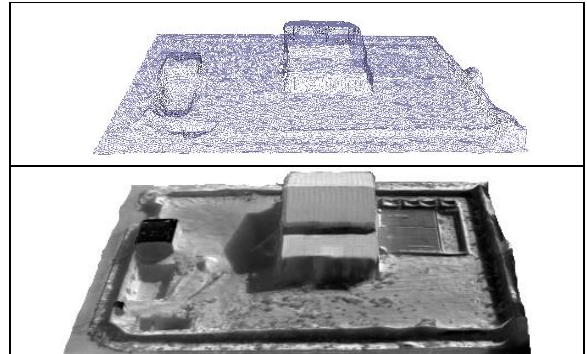
Figure 6. Triangulated and textured mesh produced by proposed